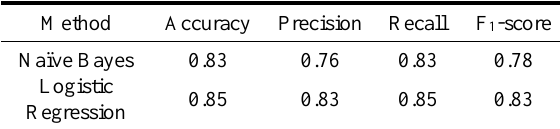
Table 3. Performance of two